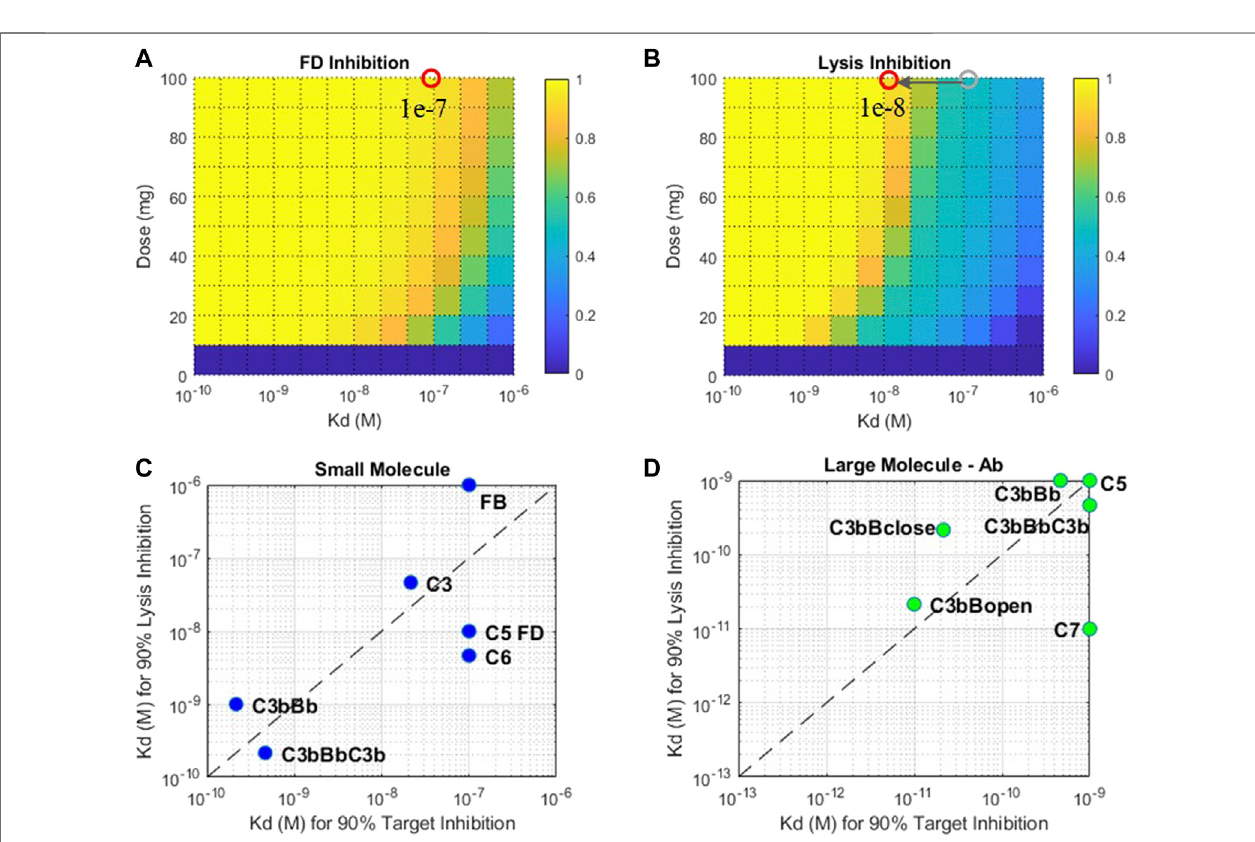
FIGURE 13 | Fractional inhibition in (A) FD and (B) cell lysis at different af fi nities (K D ) and doses of a SM modality. Drug af fi nities required for 90% target inhibition versus 90% cell lysis inhibition for (C) small-molecule and (D) large-molecule Ab modalities. Plots (C) and (D) : only the select targetsthat attain 90% TE and cell lysis are shown. The af fi nity ranges tested for SM modality — 1 μ M-0.1 nM and LM-Ab modality 1nM-0.1p.m. Af fi nity requirements predicted to be on the edges of the plots may be lower than the ranges tested.